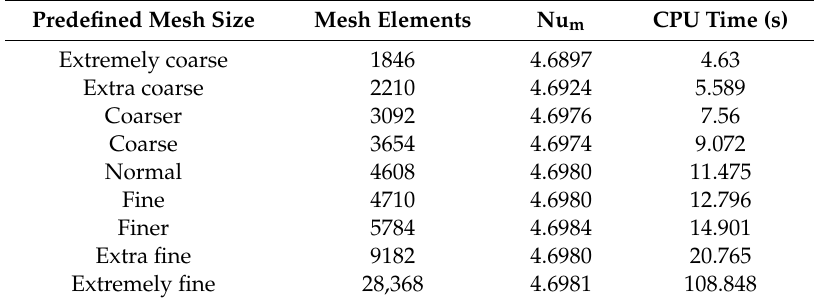
Figure 2. A schematic of the mesh distribution. Table 3. Grid sensitivity check for Ra = 10 5 , Ha = 0, ϕ = 0.04, q ∗ = 1, Da = 10 − 2 and ω = 0. Ra: Rayleigh number; Ha: Hartmann number; Da: Darcy number; ϕ : solid volume of composite nanoparticles; ω : angle of